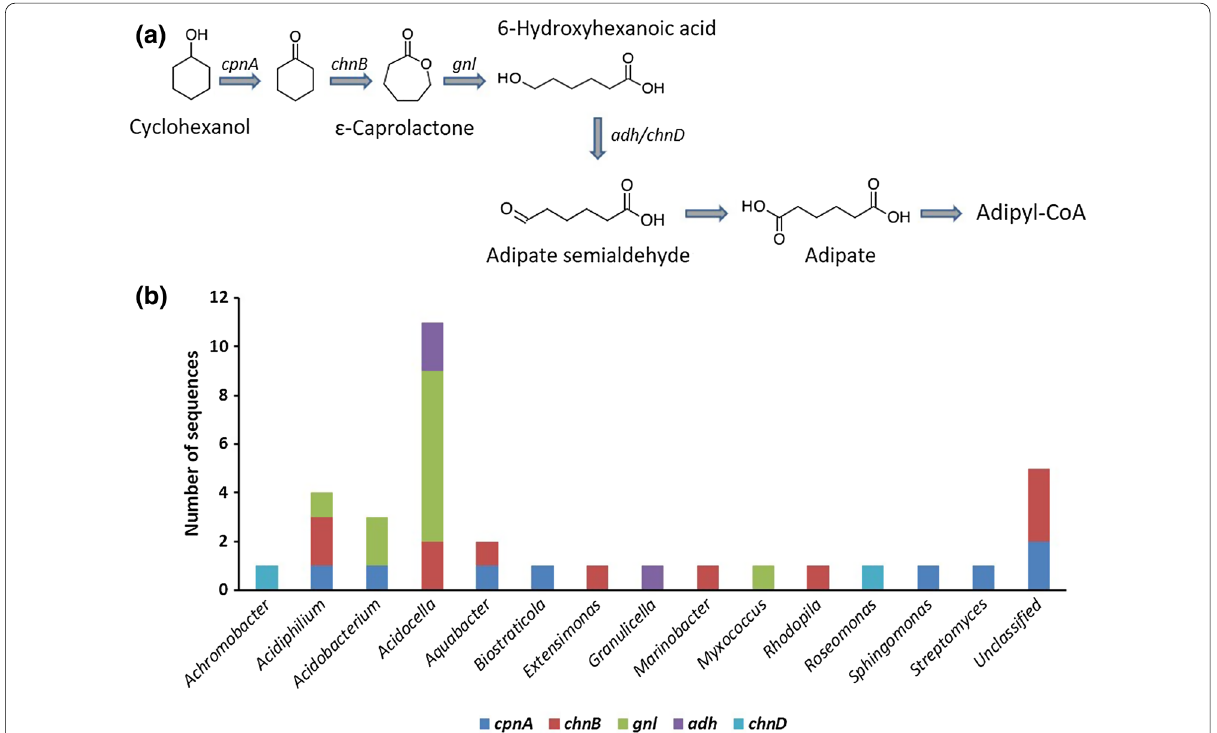
Fig. 5 a Ring cleavage via the Baeyer–Villiger oxidation pathway for the degradation of cycloalkanes, and b genus assignment of the putative genes involved in the Baeyer–Villiger oxidation pathway identified in the diesel-degrading consortium